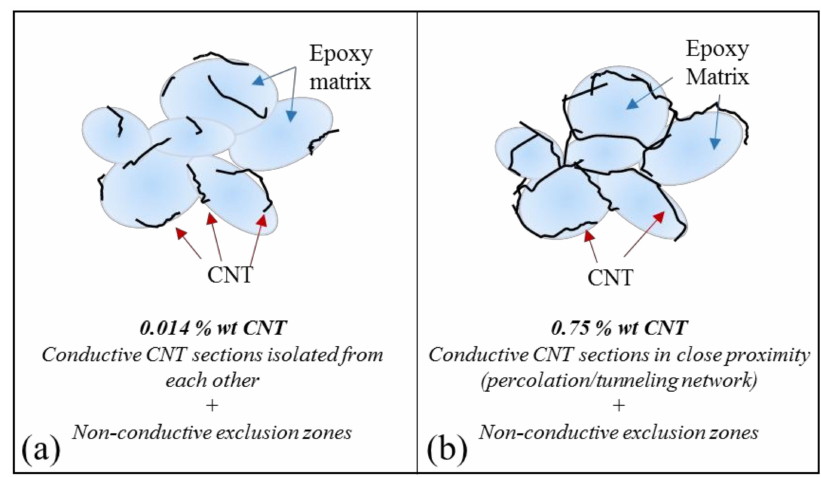
Figure 10. Pictograms of the CNT and epoxy distribution in composites containing ( a ) 0.014% wt CNT and ( b ) 0.075% wt